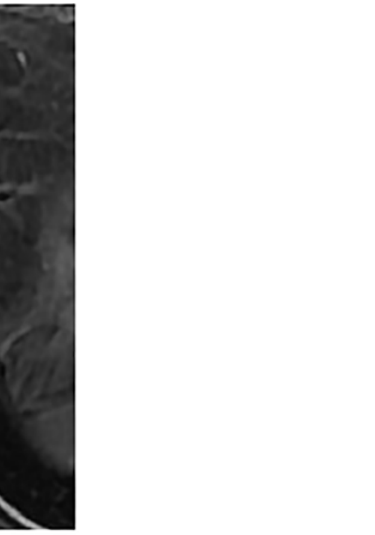
Fig 6. male, 37 years, stage I with signal grade 1 and halo sign grade